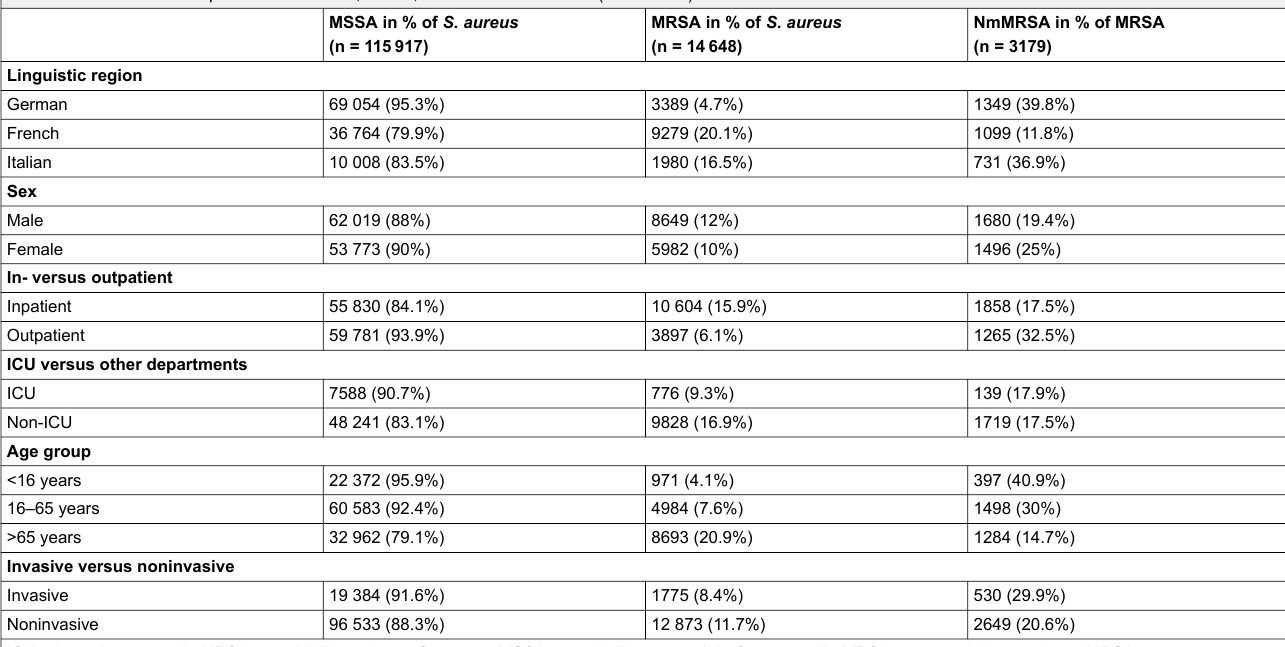
Table 1: Characteristics of patients with MRSA, MSSA, or NmMRSA infections (2004–2014). MSSA in % of S. aureus (n =